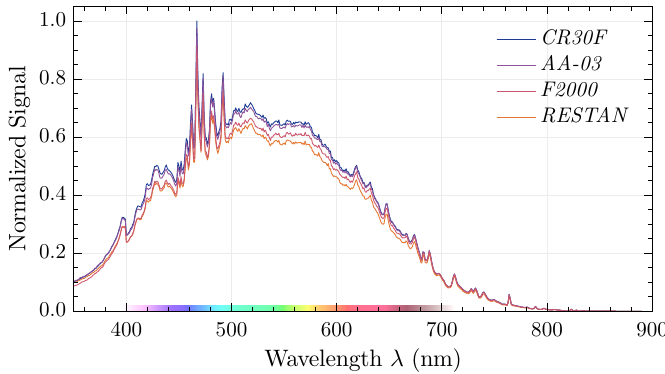
Figure 6. Comparison of the diffuse reflectance of different aluminum oxide powder pellets with equal thickness and constant excitation intensity. All diffuse reflectance have been scaled by the maximum signal of CR30F